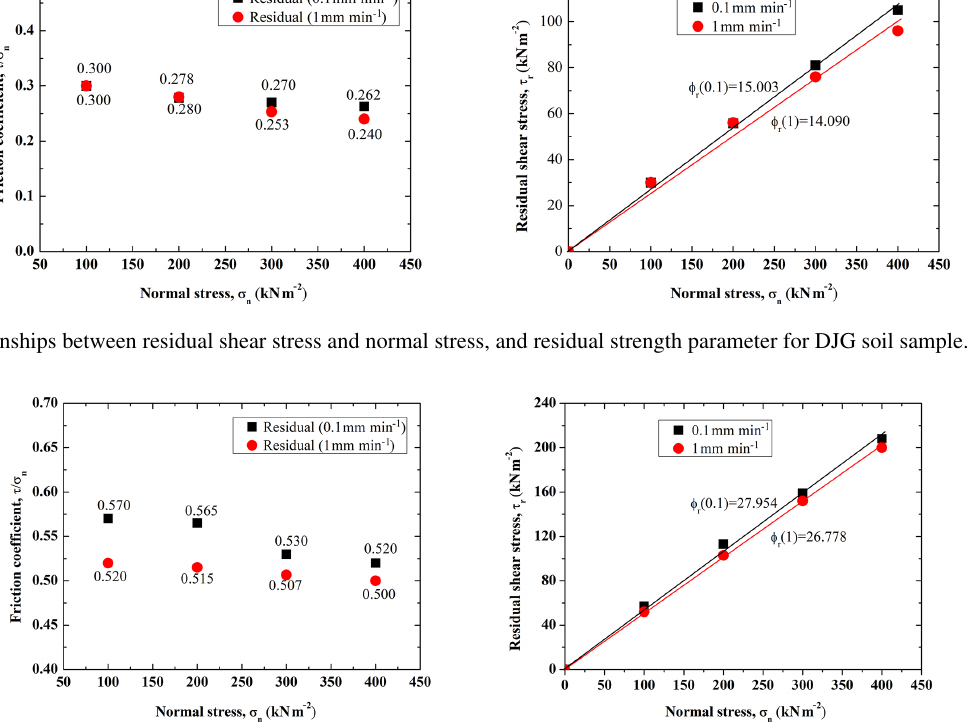
Figure 9. Relationships between residual shear stress and normal stress, and residual strength parameter for YDG soil